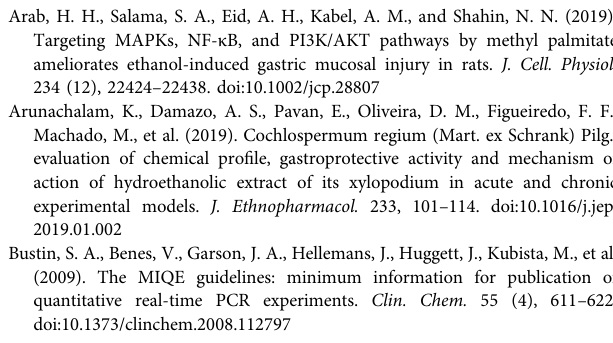
Frontiers in Pharmacology |